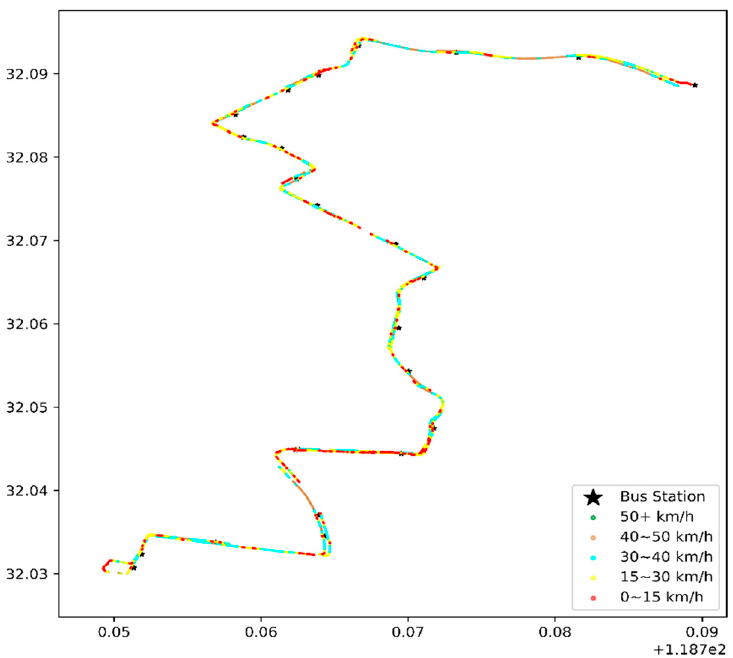
Figure 9. Heat map of the vehicle speed during morning rush hours, with the coordinates of the x-axis longitude ( ◦ E) and latitude ( ◦ N) on 1 January 2016.